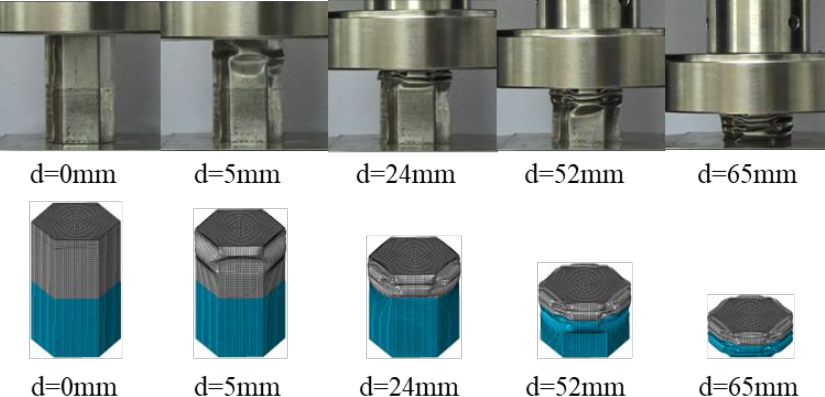
Figure 9. Comparison of two-stripe tube deformation modes by experiment and FE simulation.